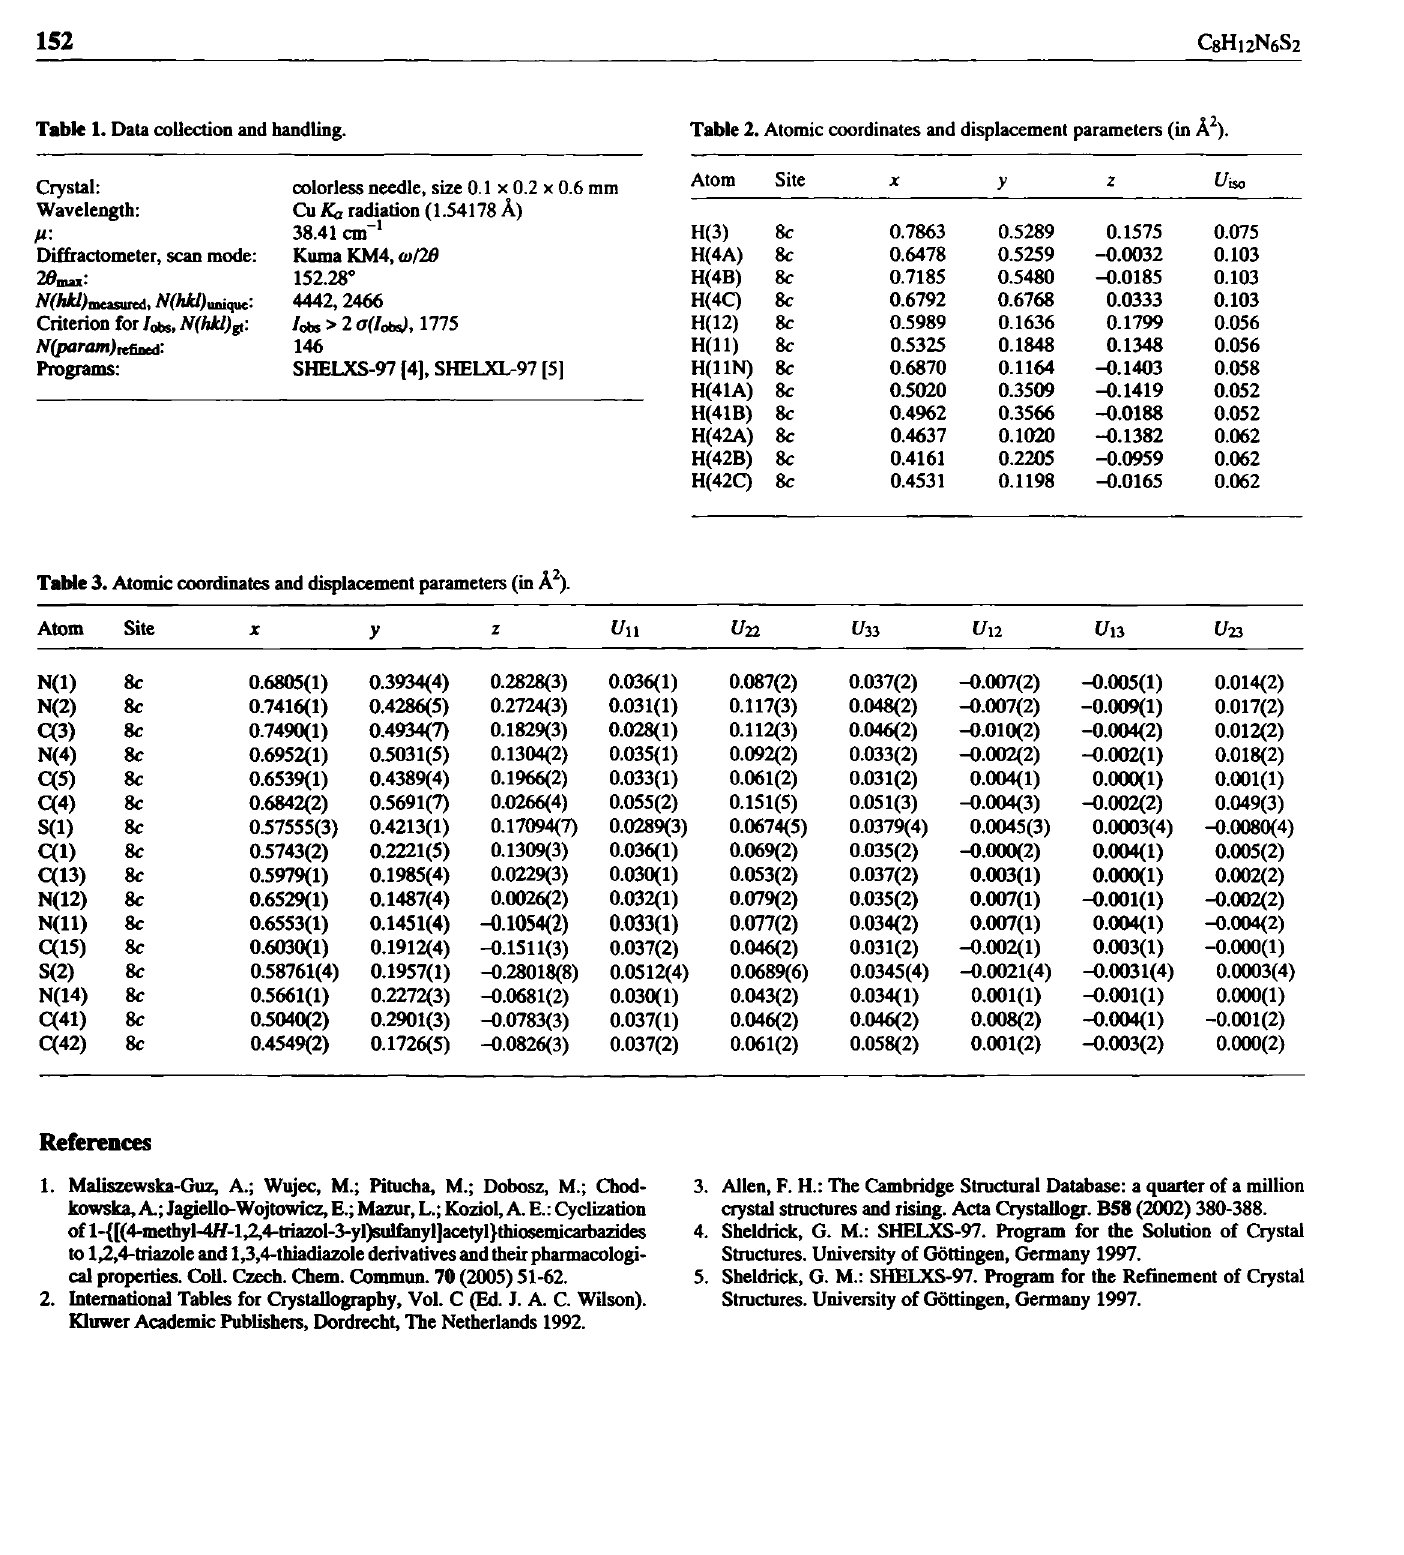
Table 1. Data collection and handling. Table 2. Atomic coordinates and displacement parameters (in Ä 2 ).